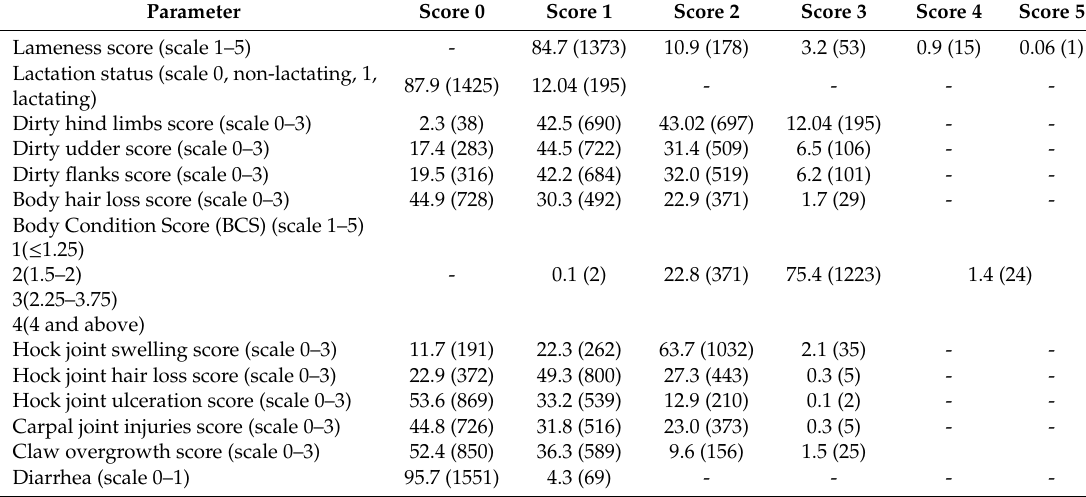
Table 2. Percentage of cows in each category (number) of animal-based welfare parameters in 54 shelters (n = 1620 cows), see text for details of scoring